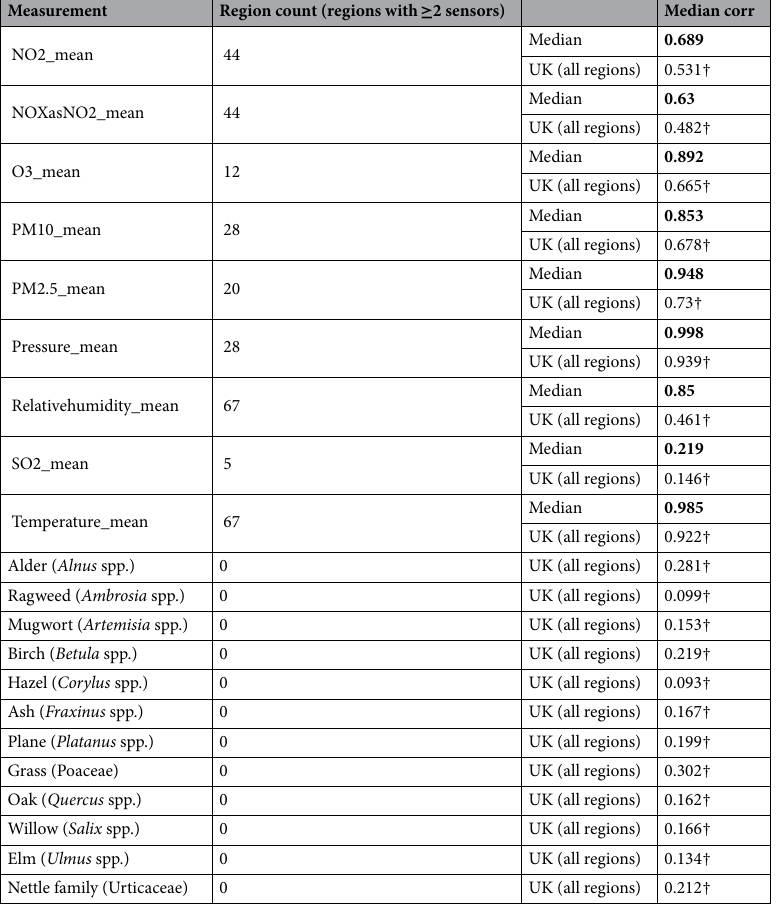
Table 6. Pollution, pollen and weather measurement: median correlations both within single postcode regions (bold), and across the whole UK ( † ). Data for March–September, inclusive, is used. Only significant correlations (those with p ≤ 0.05) are reported